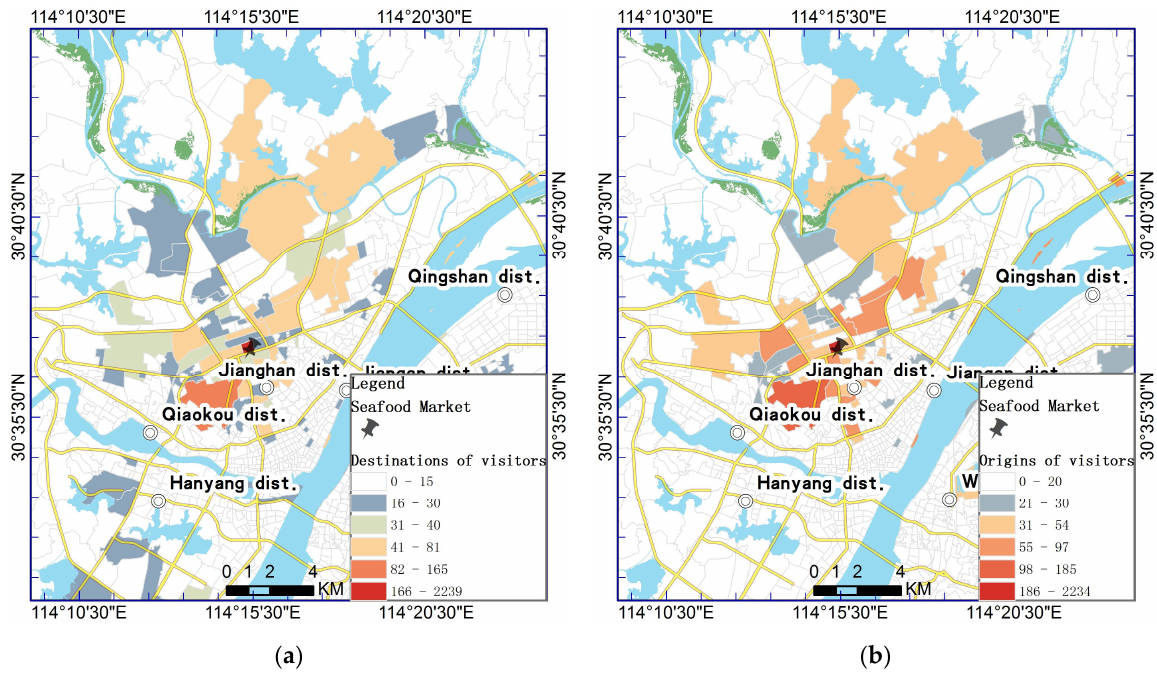
Figure 6. The distribution of the market’s visitors at the community level (( a ) The main destinations of people who traveled from the market; ( b ) The main origins of people who traveled to the market).